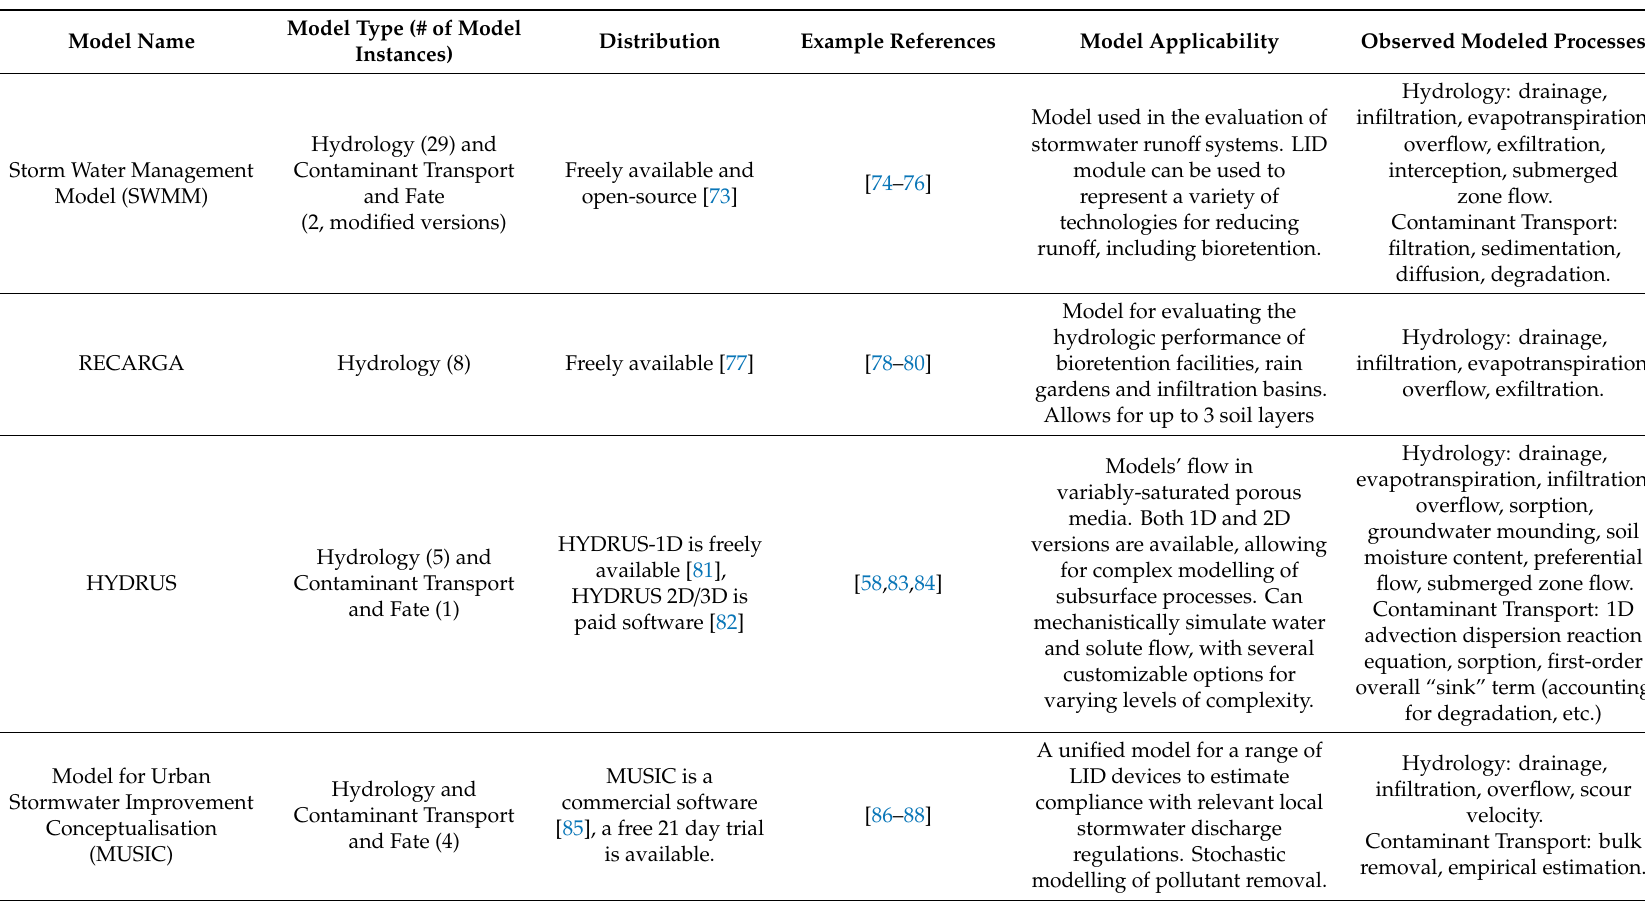
Table 3. Most commonly used models ( ≥ 3 model instances), their purpose, distribution, example references (including the first-used instance and examples of any specific uses), model applicability and model processes observed in our